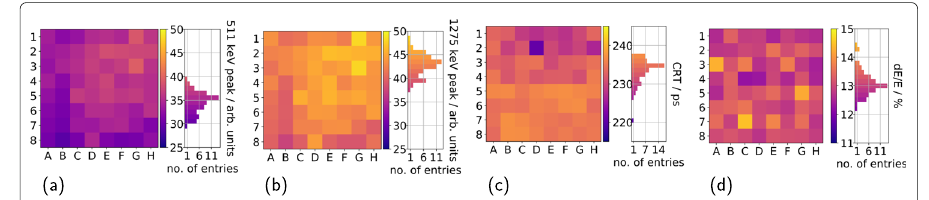
Fig. 5 Uniform channel performance. A geometry of five NEMA cubes ( 22 Na sources) with a total activity of approximately 3 MBq is employed. a Position of the 511-keV peak in the energy value spectrum. b Position of the 1275-keV peak in the energy value. c Coincidence resolution time (CRT) computed as the mean of the CRTs of this channel with all its coincident channels. d Energy resolution (dE/E). Measurements were conducted with two Hamamatsu S14161-350-HS-08 SiPM arrays at 4 V overvoltage and vth_t1 = 50. BaSO 4 powder (360 μ m) mixed with an epoxy was used as segmentation layer. The scintillator array used consists of 8 × 8 needles with a size of 3 mm × 3 mm × 12